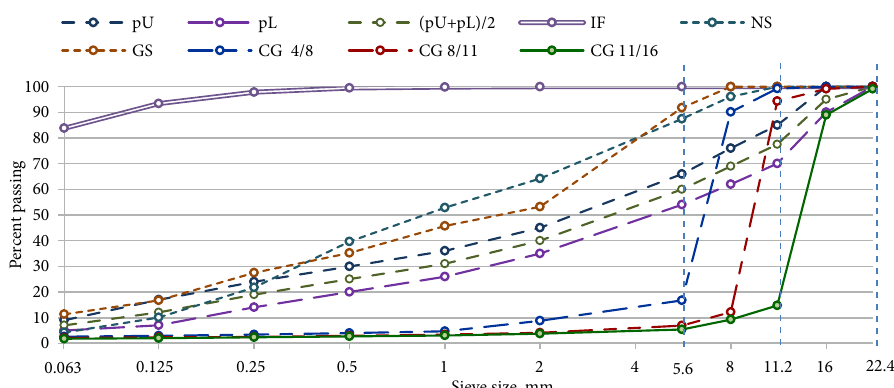
Fig. 1. The gradation curves of mineral materials, limit curves and the gradation curve of the ideal asphalt mixture